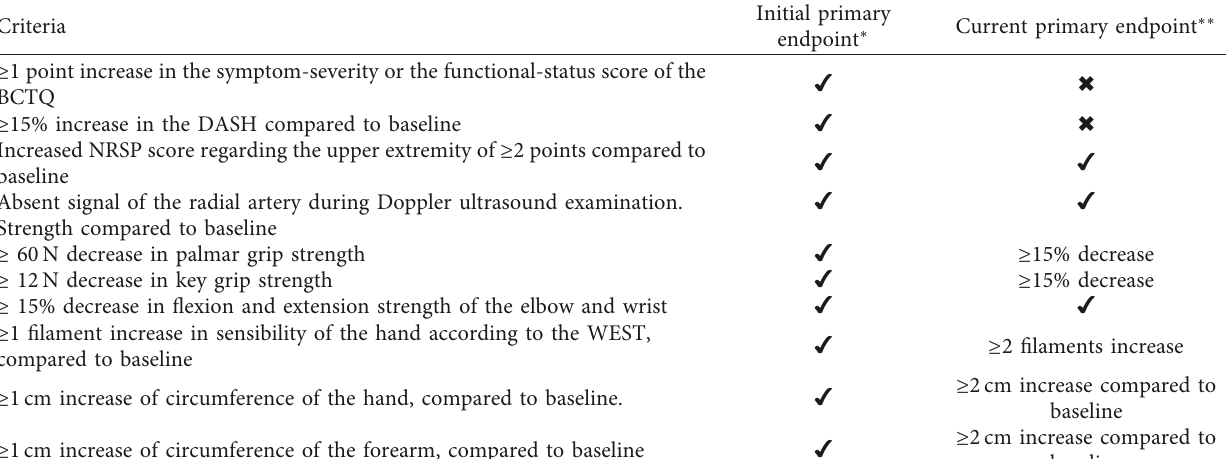
Table 1: Composed primary endpoint: Upper Extremity dysfunction at two